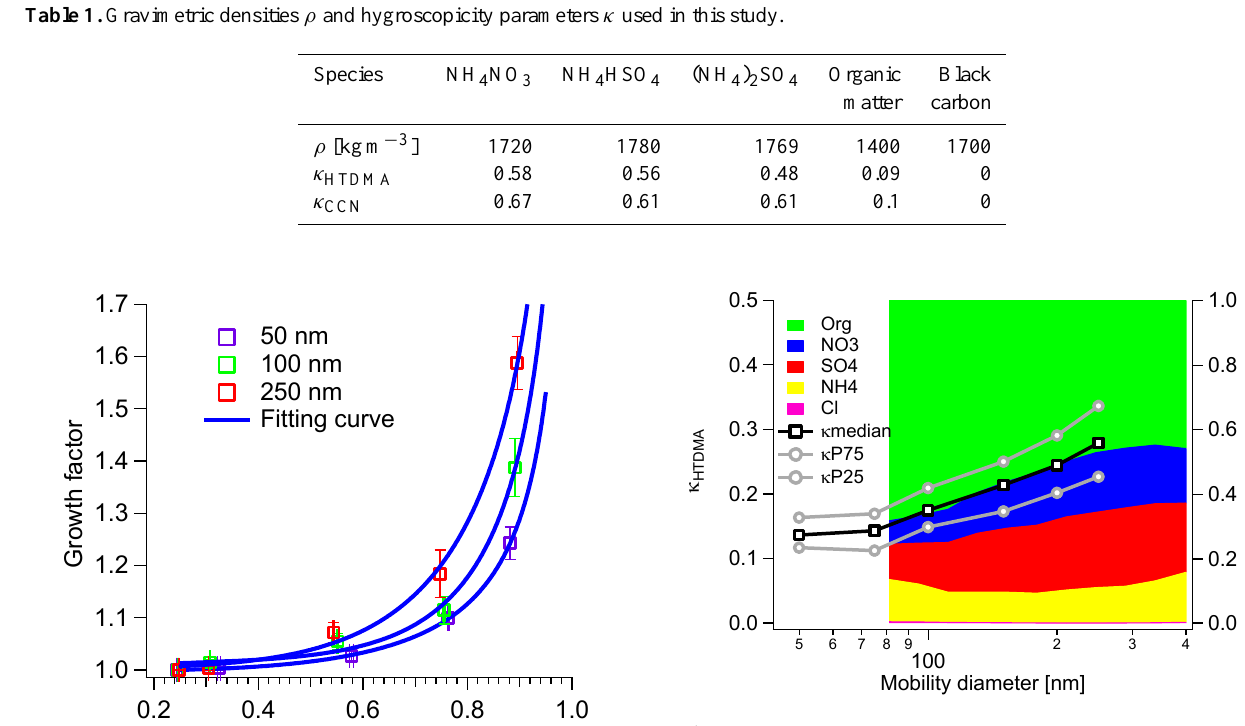
Table 1. Gravimetric densities ρ and hygroscopicity parameters κ used in this study.